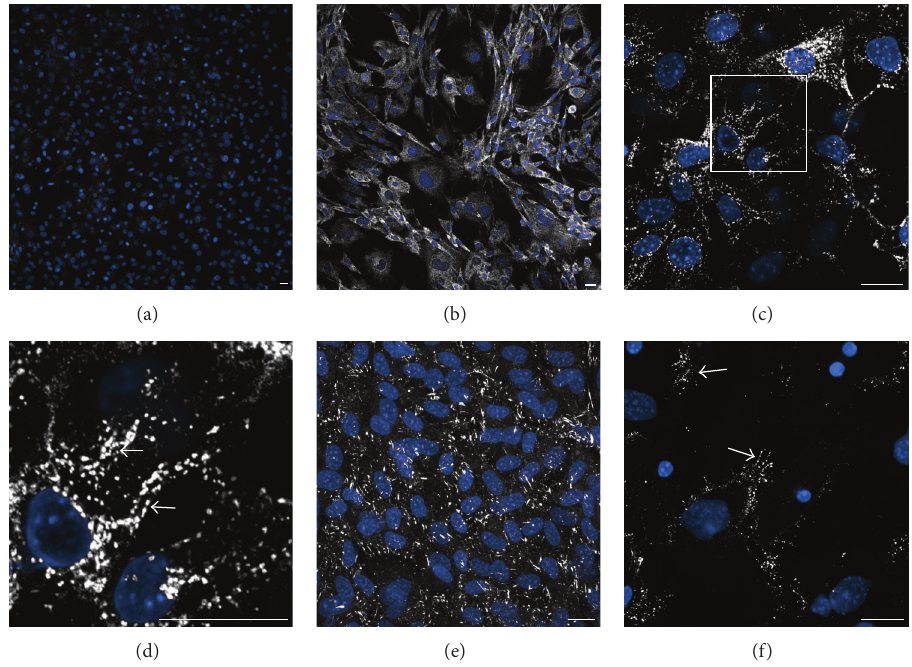
Figure 7: Sarcomeric protein expression of bone marrow-derived PBCs. (a) MSCs cultured with CCM but unexposed to BIX01294 or (b–f) PBCs collected from BIX01294 plus CCM-treated MSCs were subsequently treated with dexamethasone and aggregated as a hanging drop prior to dual fluorescent staining with antibody (gray) and DAPI (blue). (a) Individual control culture showing titin and DAPI staining. Note the absence of gray signal indicating that non-BIX01294-treated control cultures were not labeled with the titin antibody. (b) In contrast, BIX01294 induced PBCs showed widespread titin expression when placed under differentiation conditions. (c) High magnification view of aggregated PBC cultures stained for titin, which on close-up view of the boxed region (d) indicated that titin protein was becoming organized within the cells (arrows). (e) Muscle 𝛼 -actinin was also broadly distributed in MSC-derived PBC cultures, (f) which at higher magnification showed evidence of becoming organized (arrows). Scale bar = 20 𝜇